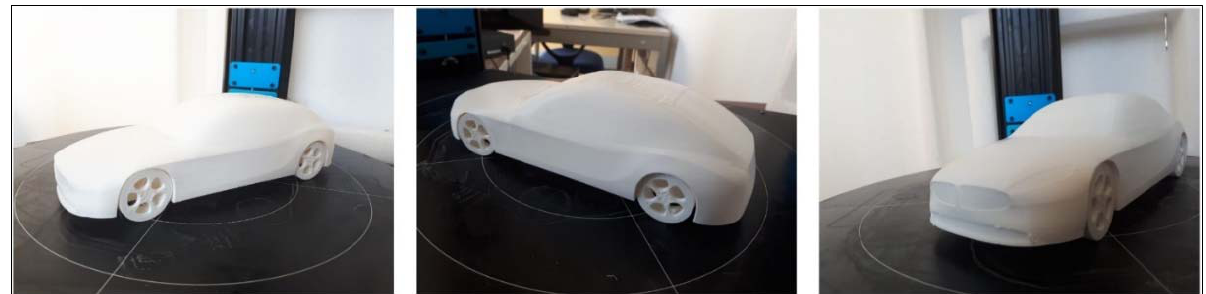
Figure 21. Augmented reality implementation of the two models.